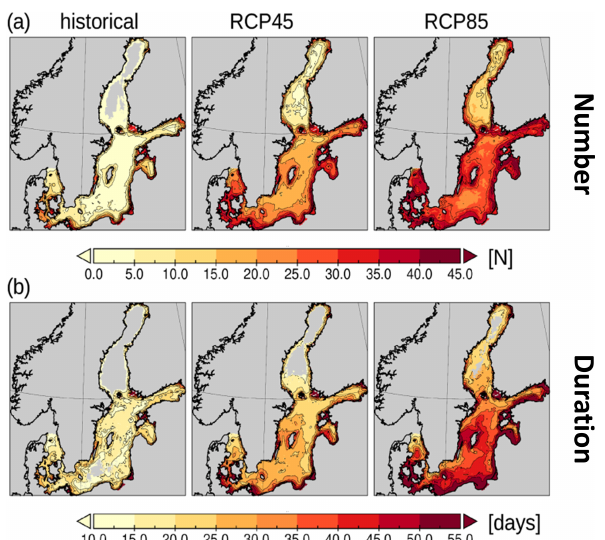
Figure 19. Same as in Fig. 18 but for heat waves defined as periods of ≥ 10d in which the water temperature exceeded the 95th per- centile of the historical reference temperature. (Data source: Meier et al.,